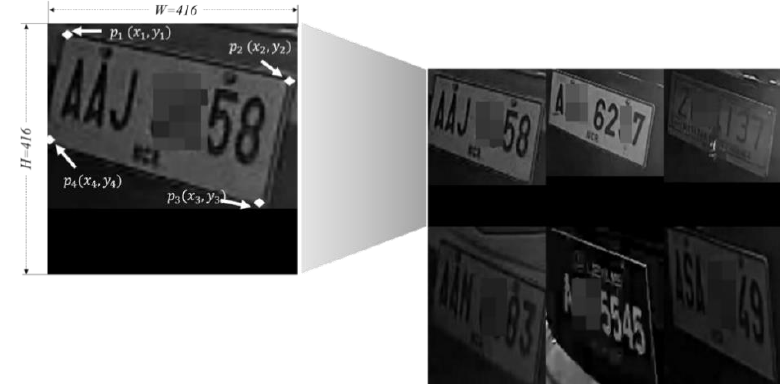
Figure 1. Example plate images from data set. Each image contains a single randomly oblique plate with size of 416 × 416. We manually mark four corners of p i , 1 ≤ i ≤ 4, for supervised training. The plate numbers are partly blurred for privacy reasons.